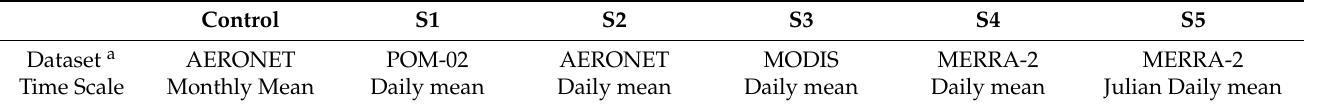
Table 1. Numerical simulation design for sensitivity tests of the aerosol optical depth. Sensitivity tests, i.e., S1 to S5 are performed for the different datasets of aerosol optical